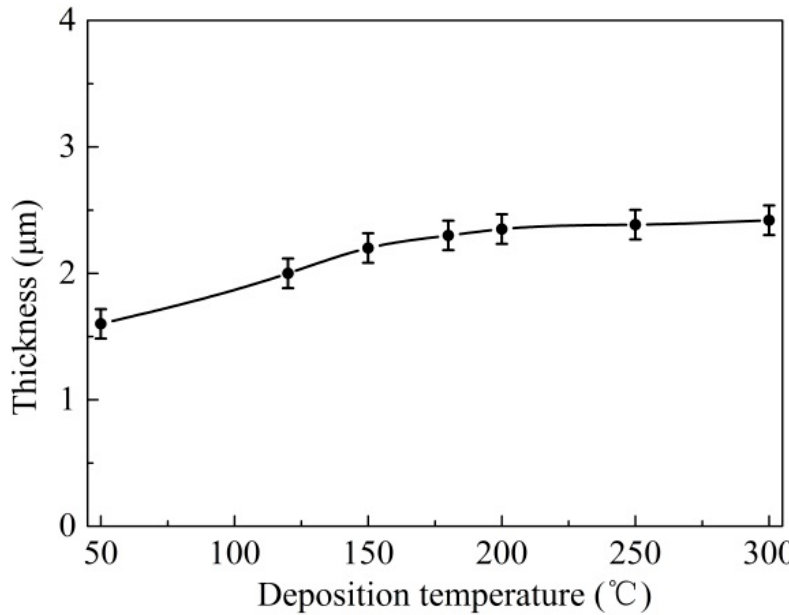
Figure 8. Coating thickness at different deposition temperatures.